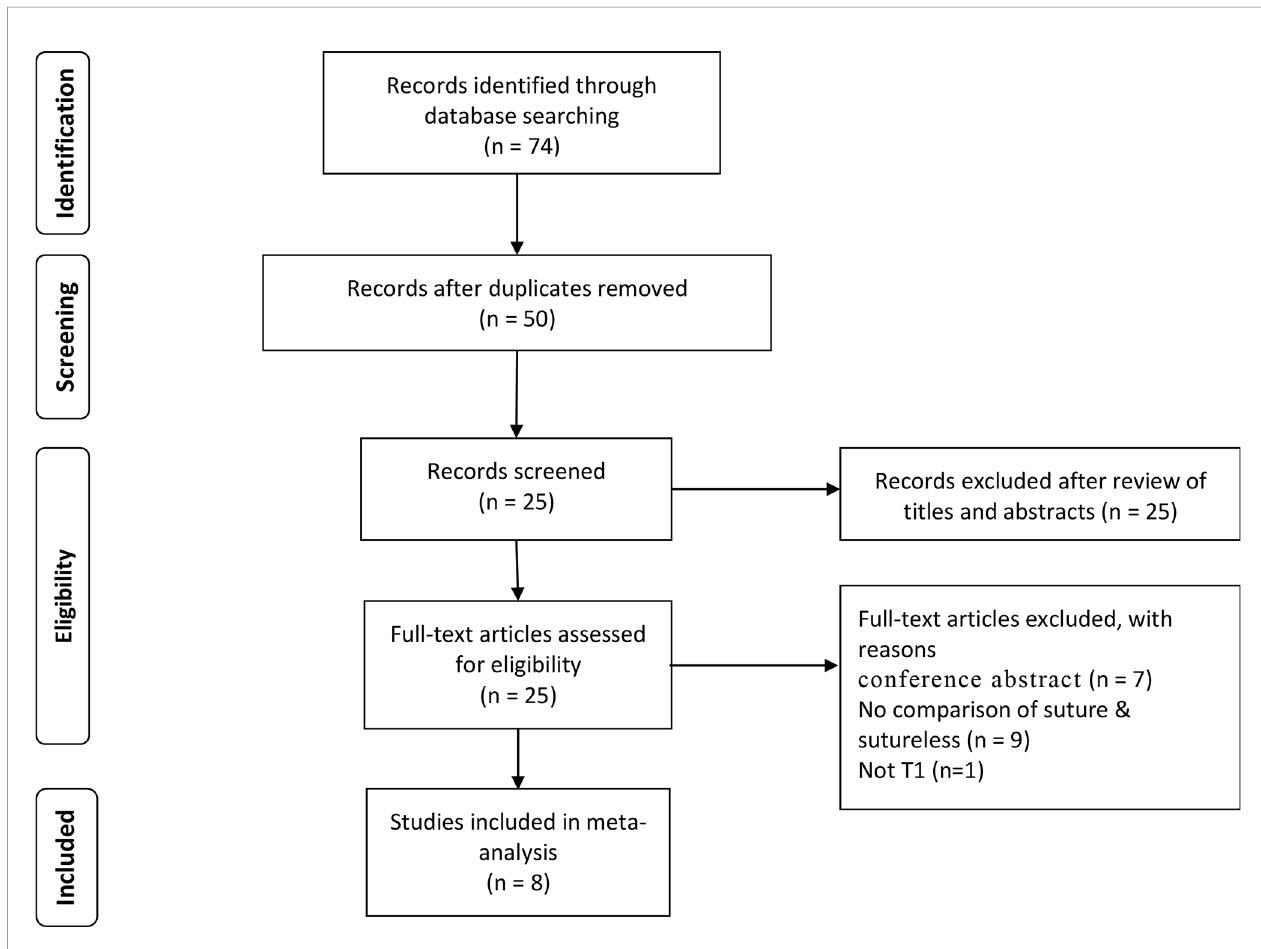
FIGURE 1 | PRISMA fl ow chart of the study identi fi cation